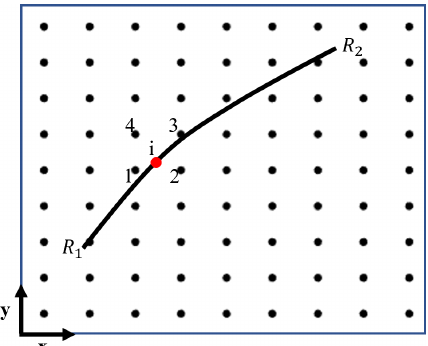
Figure 1. The ray path between receivers R 1 and R 2 at a generic frequency is represented by the solid black line. The phase slowness for any discretised point ( i ) along the path is computed based on the values of its four adjacent grid points using a bilinear interpolation (Eq. 3; See also Boiero,